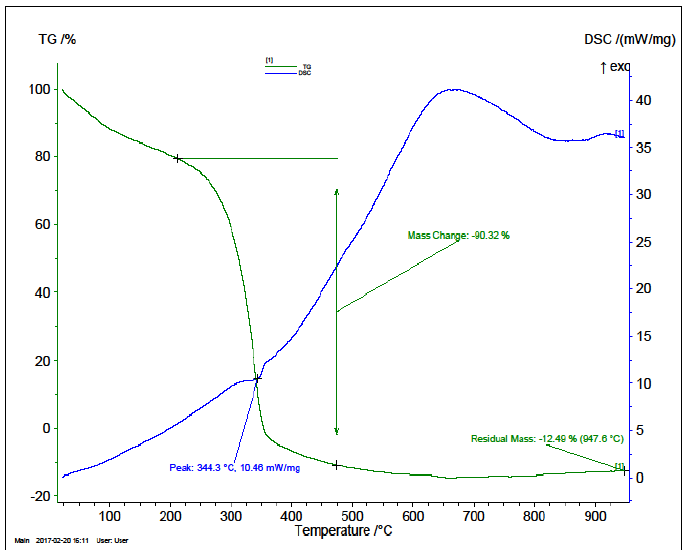
Figure 7. TGA and DSC curve of cellulose.